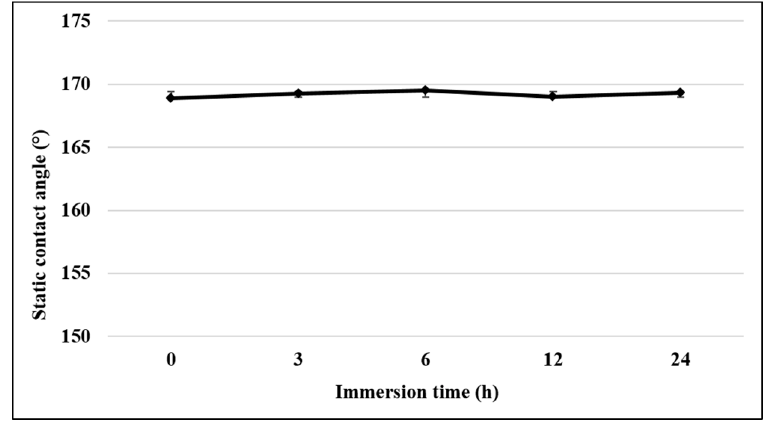
Figure 5. Effect of immersion time on the static water contact angle of the superhydrophobic copper surface.